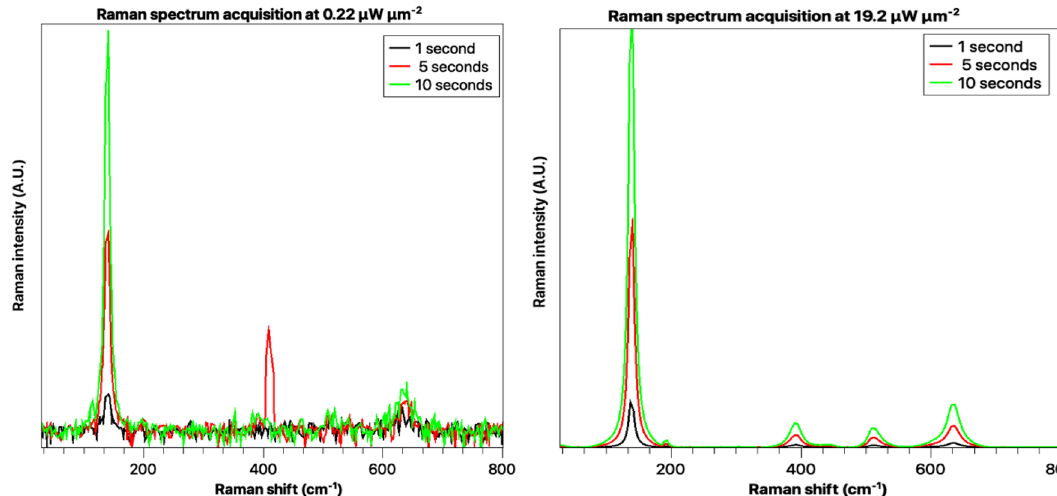
Figure 8. The figure shows the anatase spectrum at different excitation power densities and different integration times. Increasing integration time and the incident excitation power improves the SNR, which improves the spectrum’s